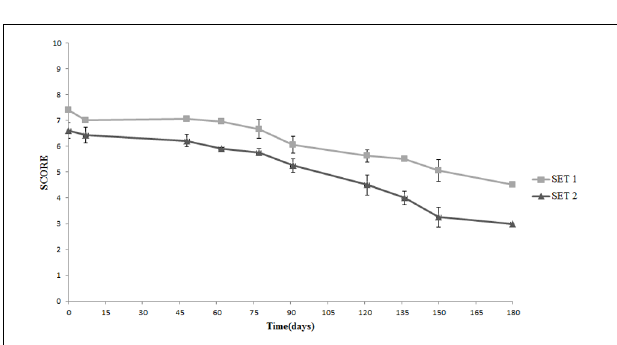
FIGURE 9 | Sensory analysis: evolution of the texture in Spanish-style olives packaged in PTE bags and stored at 4 ◦ C: SET1 (bio-preserved), and SET2 (control). Means and standard deviations were obtained from measurements made in duplicate packages from two different experiments ( n =